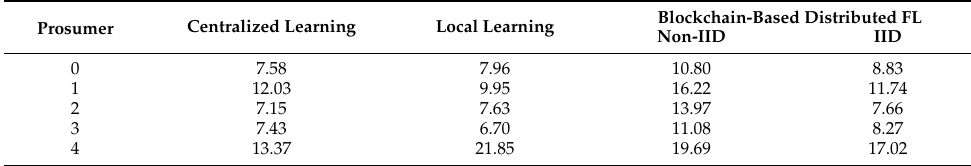
Table 4. Average MAPE results for prosumers’ test cases considered.